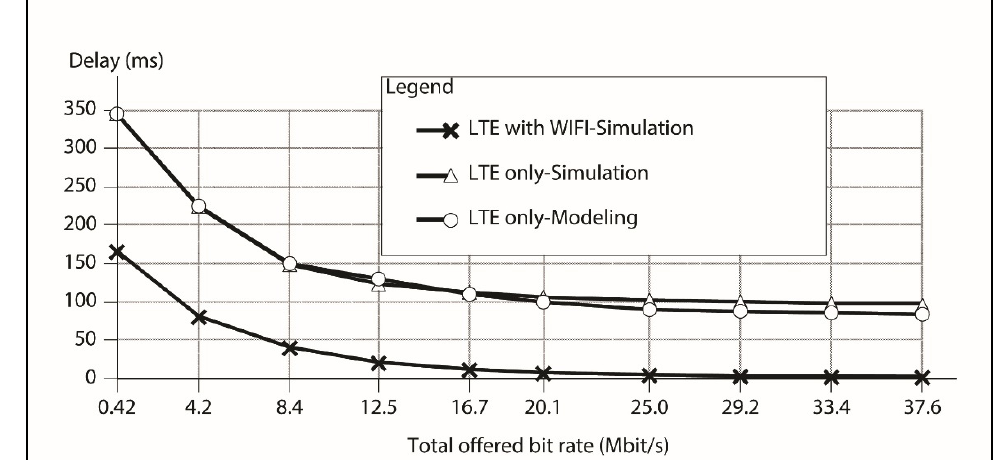
Figure 12. Delay comparison.